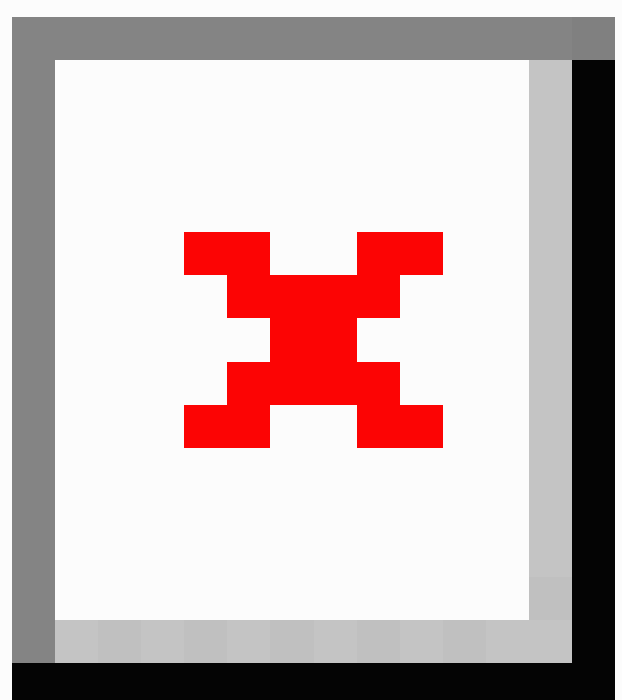
Between-Cluster Differences